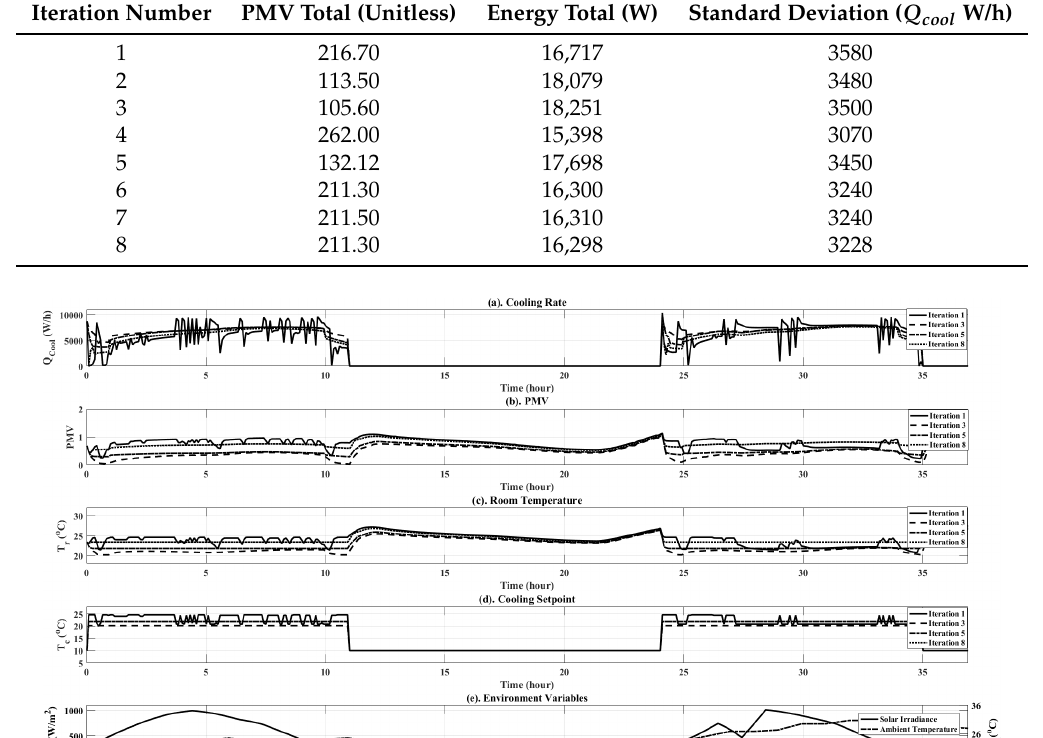
Table 2. RL training results.